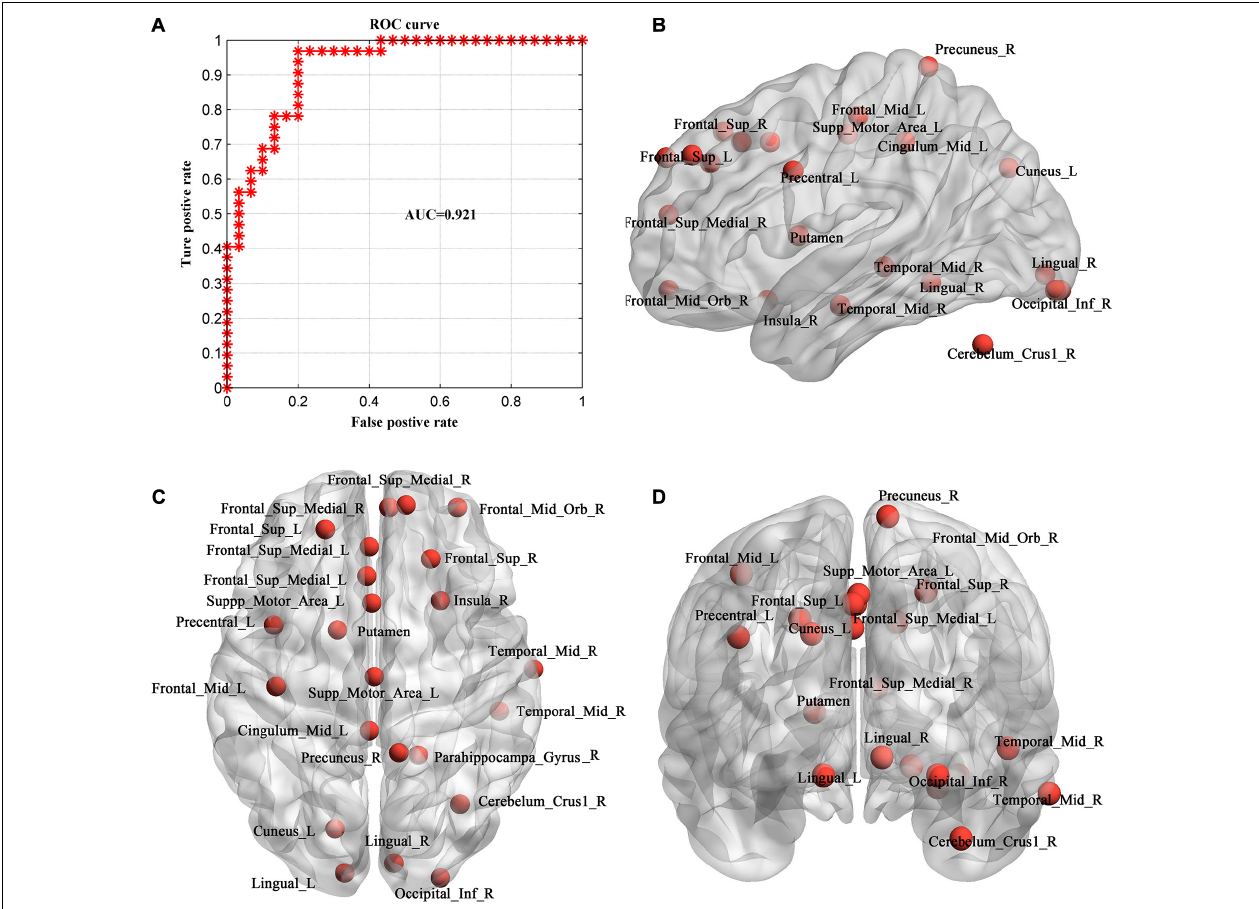
FIGURE 6 | Evaluation of individual MHE discrimination classifier. (A) ROC curve of the classifier. (B–D) The consistent discriminant nodes in SVM classification showing in sagittal (B) , axial (C) and coronal planes (D) . MHE, minimal hepatic encephalopathy. ROC, receiver operating characteristic; AUC, = area under ROC